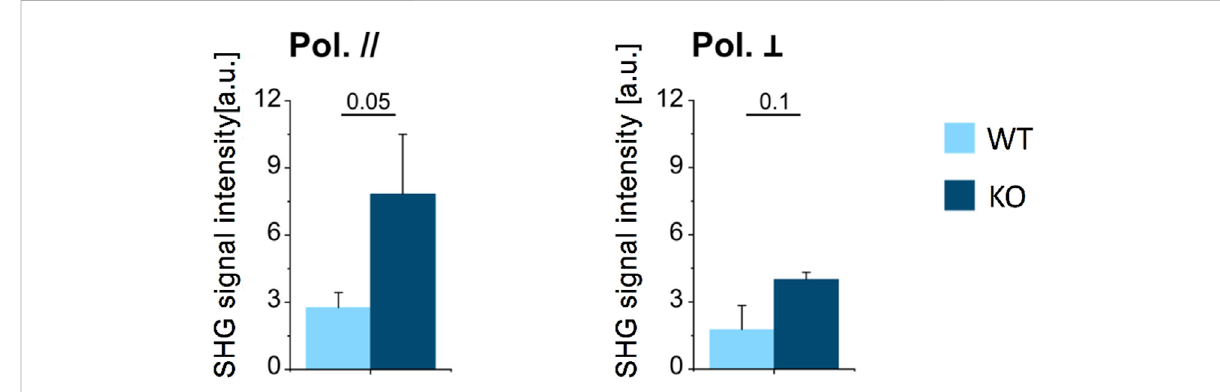
FIGURE 4 Average SHG signal intensity in mineralized bone (cortical and trabecular bone) in WT and KO mice, for parallelly- (left) and perpendicularly (right) polarized excitation laser fi eld. Data were analysed using t test ( n = 3 for both genotypes); p values are indicated above each bar